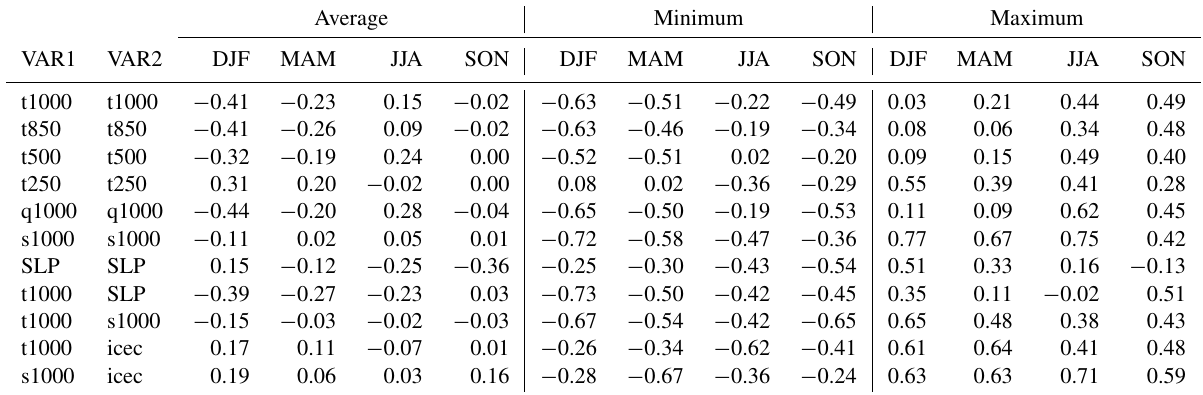
Table 1. Areal average and minimum and maximum of seasonal correlations between VAR1 at TP and VAR2 at the Greenland sector (20–80 ◦ W, 55–80 ◦